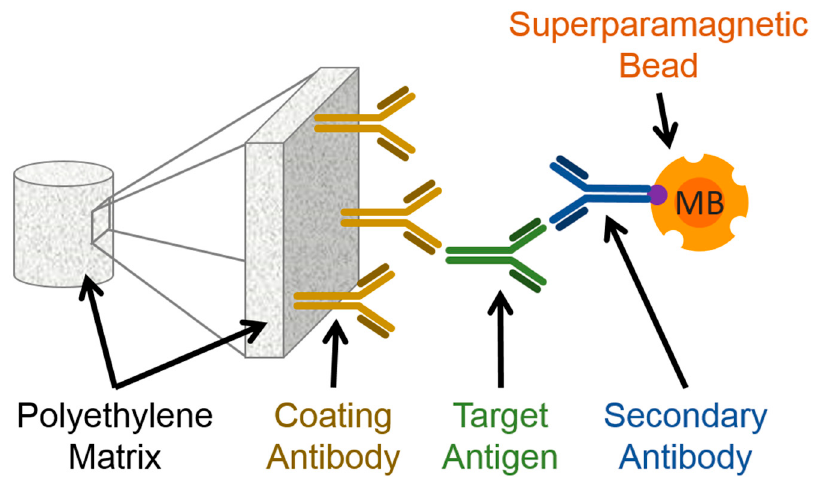
Figure 1. Schematic representation of the magnetic sandwich immunofiltration assay. A coating antibody (also primary antibody, here GAH-Fc or GAM-Fc) is immobilized on a polyethylene matrix. The target antigen (rAb M12 or respectively mAb 54k) is captured by the antibody when the antigen-containing solution is flushed over in gravity flow. As the next step, the secondary antibody (GAH- λ -biotin or GAM-F(ab) 2 -biotin respectively) is flushed over, which also binds to the target antigen. Finally the streptavidin-coated superparamagnetic beads (MB) bind to the biotin moiety of the secondary antibodies.